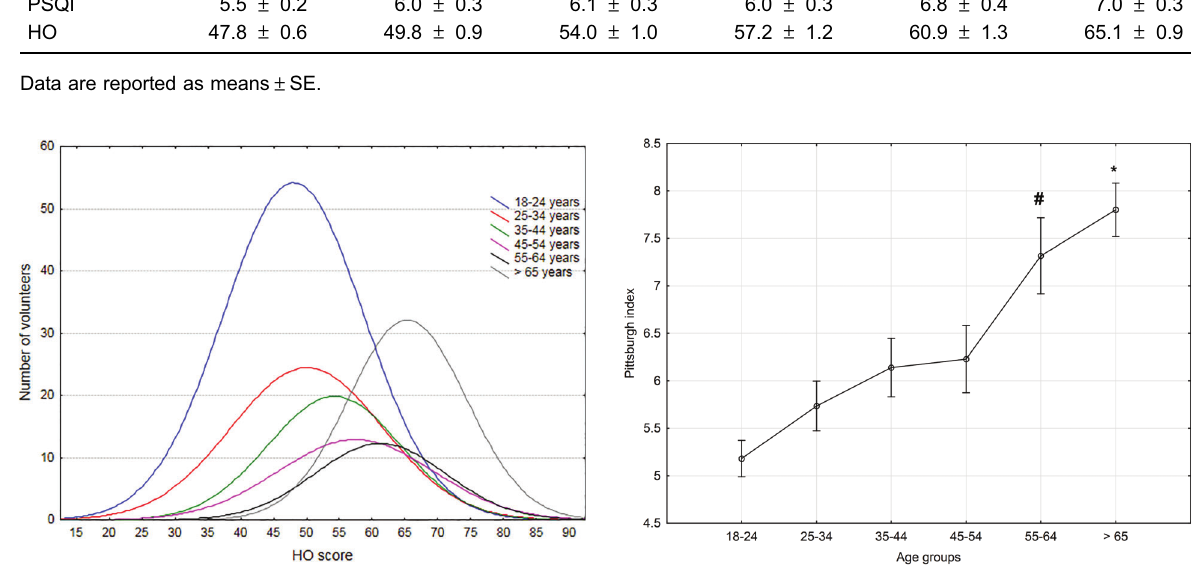
Figure 1. Horne and Östberg (HO) questionnaire score distribu- tion according to age group. Higher scores indicate greater morningness.